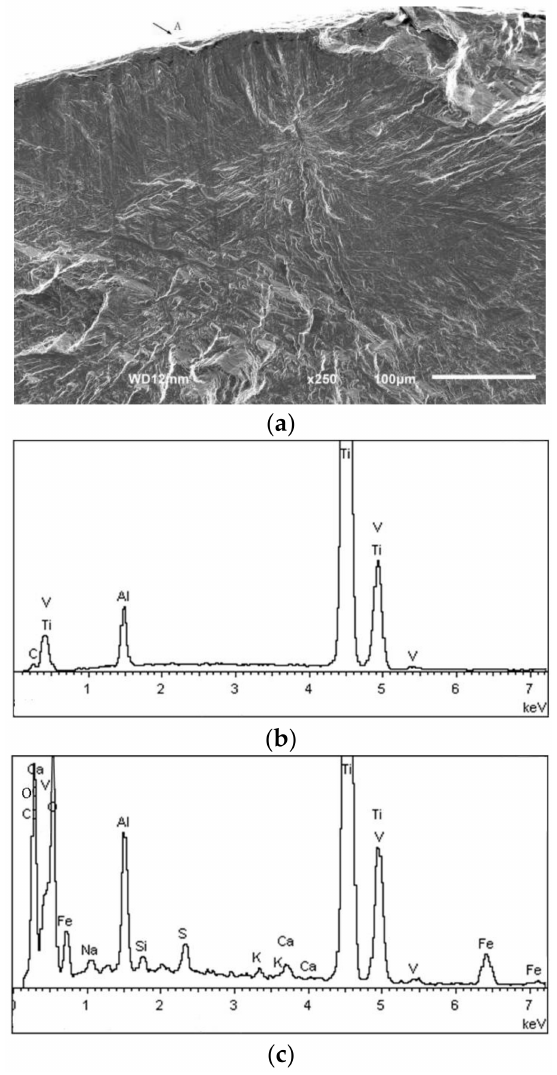
Figure 9. Fracture surface of TC4 (IS-SBF, 540 MPa, 1.95 × 10 7 cycles): ( a ) crack initiation; ( b ) EDX analysis of crack initiation; ( c ) EDX analysis of point A.